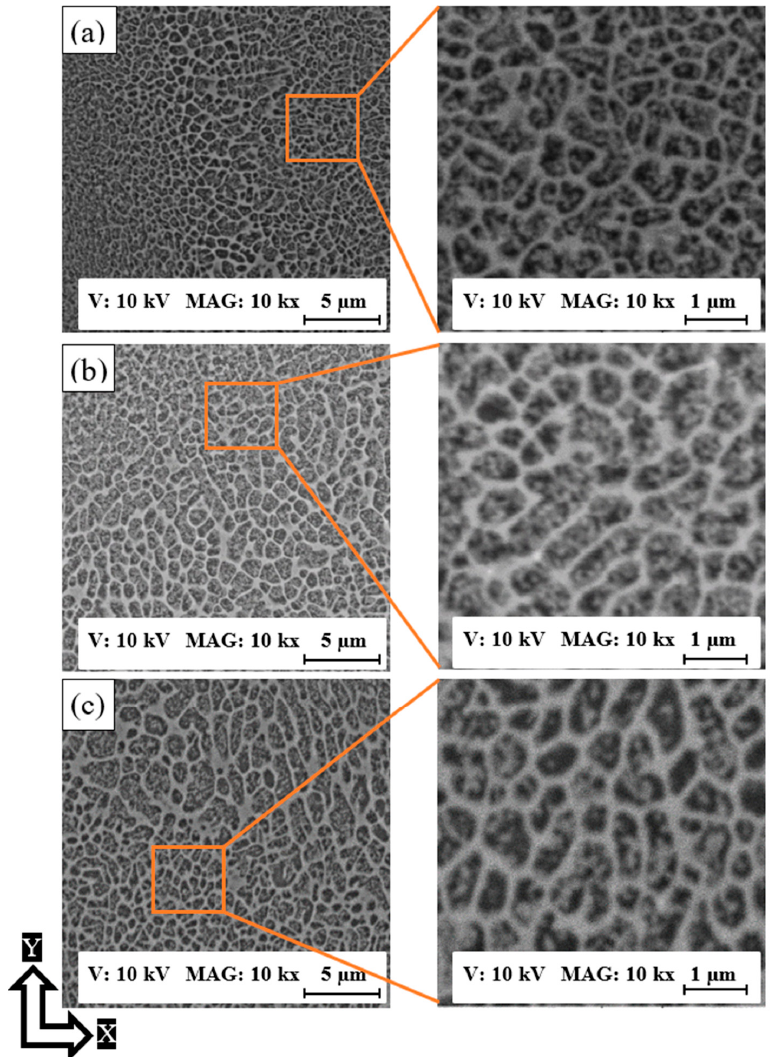
Figure 3. The SEM observations of the as-built AlSi10Mg microstructure along the XY plane; ( a ) AS8; ( b ) AS3, and ( c ) AS1. ( b ) AS3, and ( c )